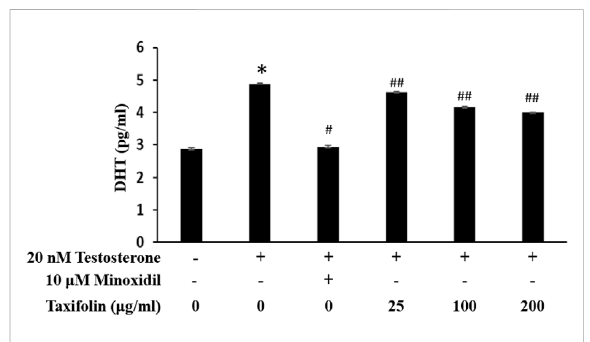
Inhibitory effect of taxifolin on testosterone-induced DHT productioninHDFPC.Cellswerepre-incubatedwiththeindicated concentration of taxifolin for 20 min and further treated 20 nM testosterone for 12 h. The concentration of DHT were analyzed from cell lysate as described in Materials and methods . Data are expressed as the Mean ± SD. * p < 0.001 vs.